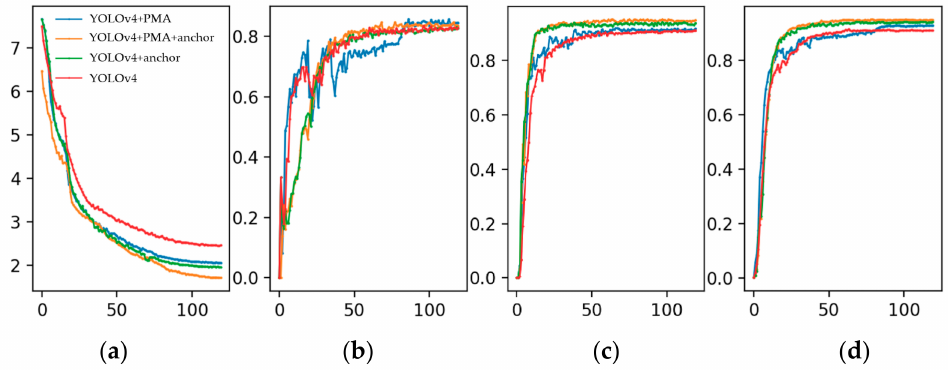
Figure 22. Graphs of the loss function and evaluation metrics during training: ( a ) loss function; ( b ) precision; ( c ) recall; ( d ) mAP